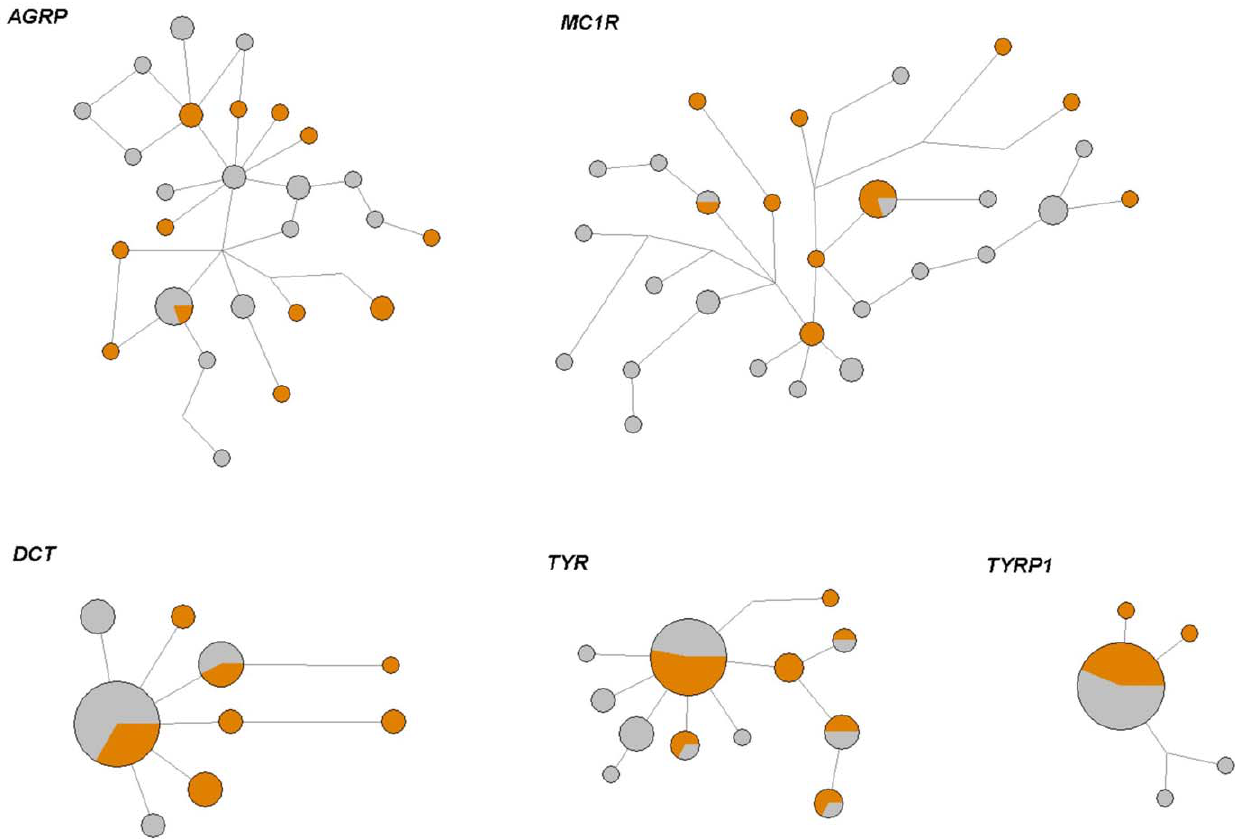
Figure 1. Median-joining haplotype networks of phased sequences. Scandinavian Willow grouse and Scottish Red grouse sequences are represented with grey and red, respectively. Node size is proportional to haplotype frequency.